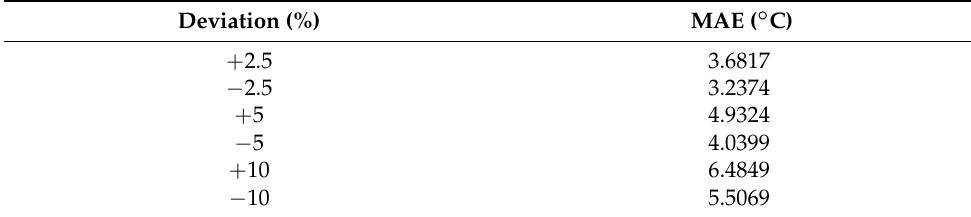
Table 5. MAEs obtained for different deviations in the sensor